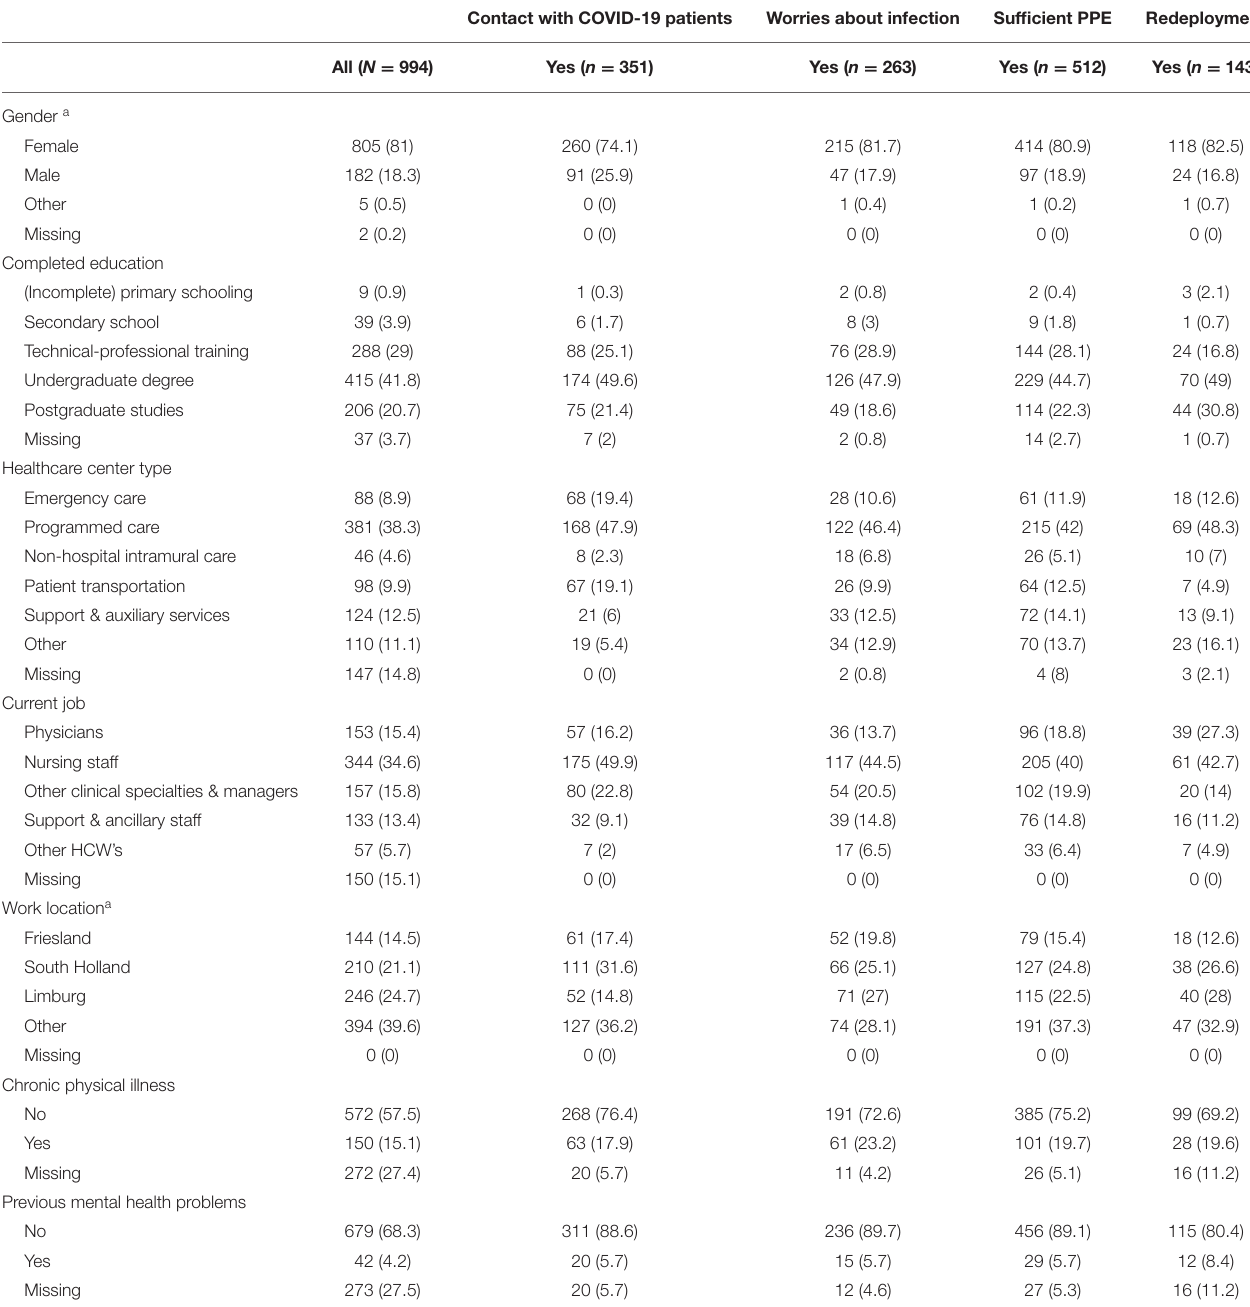
TABLE 2 | Participants’ characteristics [ n (%)] for the whole sample and stratified by reported contact with COVID-19 patients, worries about infection, sufficient PPE, and redeployment. Contact with COVID-19 patients Worries about infection Sufficient